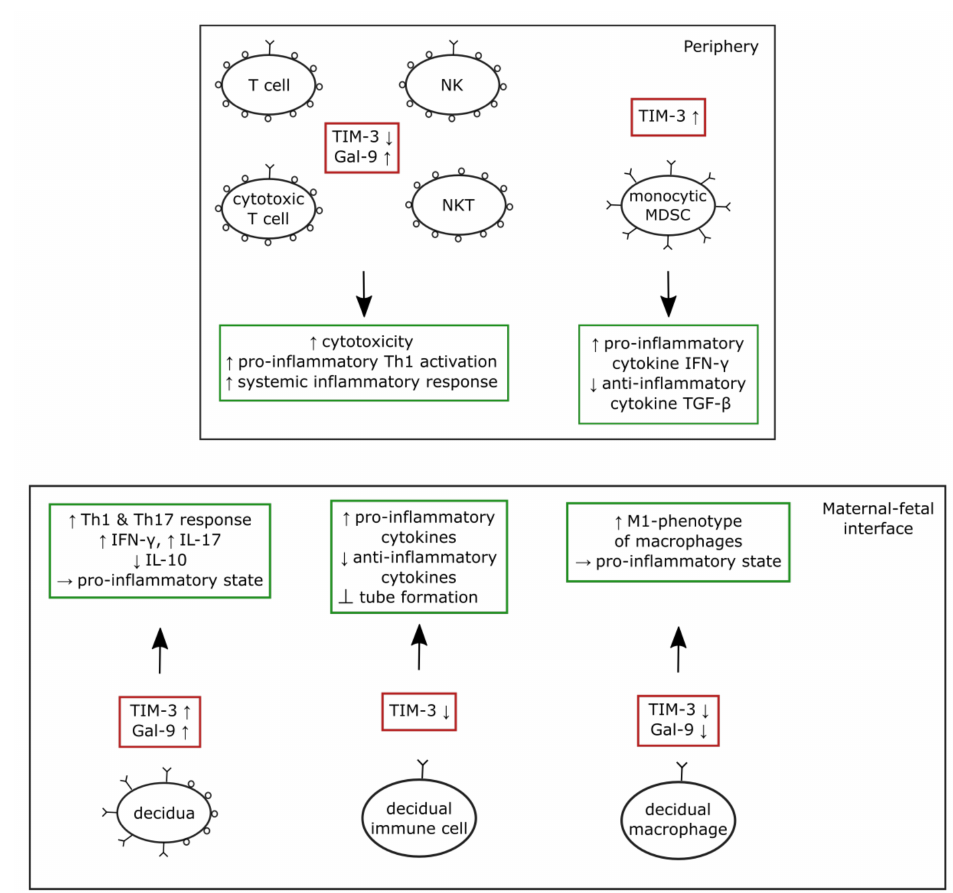
Figure 2. Summary of the described alterations of the TIM-3/Gal-9 system in the periphery and maternal-fetal interface in preeclampsia and their effects on the immune system. Abbreviations: TIM-3—T cell immunoglobin and mucin domain-containing protein 3; Gal-9—Galectin 9; NK— natural killer cell; NKT—natural killer T cells; MDSC—myeloid-derived suppressor cell; IFN- γ — Interferon- γ ; TGF- β —transforming growth factor β ; Th1—T helper 1 cell; Th17—T helper 17 cell; IL-17—Interleukin 17; IL-10—Interleukin 10; ⊥